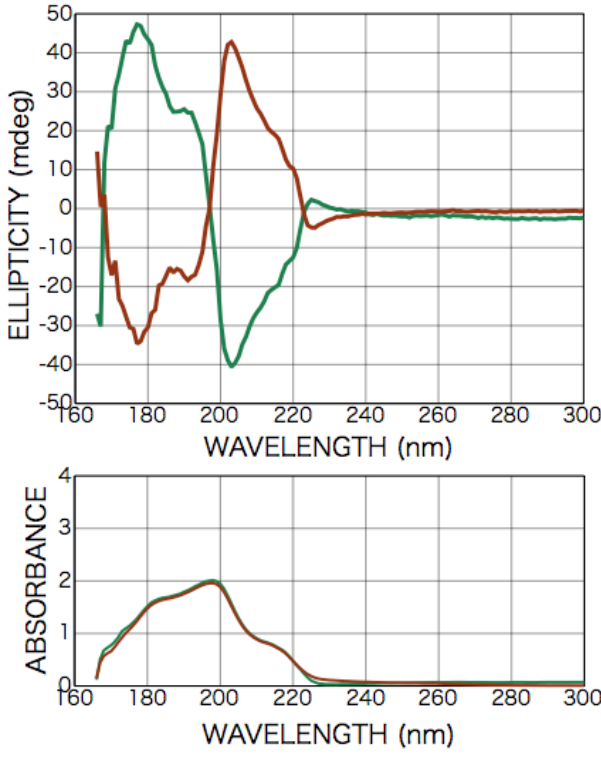
Figure 2. CD and photo absorption spectra of as-deposited D - (brown) and L -phenylalanine (green) films (200-nm in